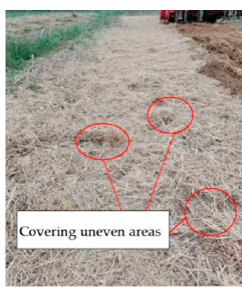
Figure 2. Image of poor uniformity of straw mulching.